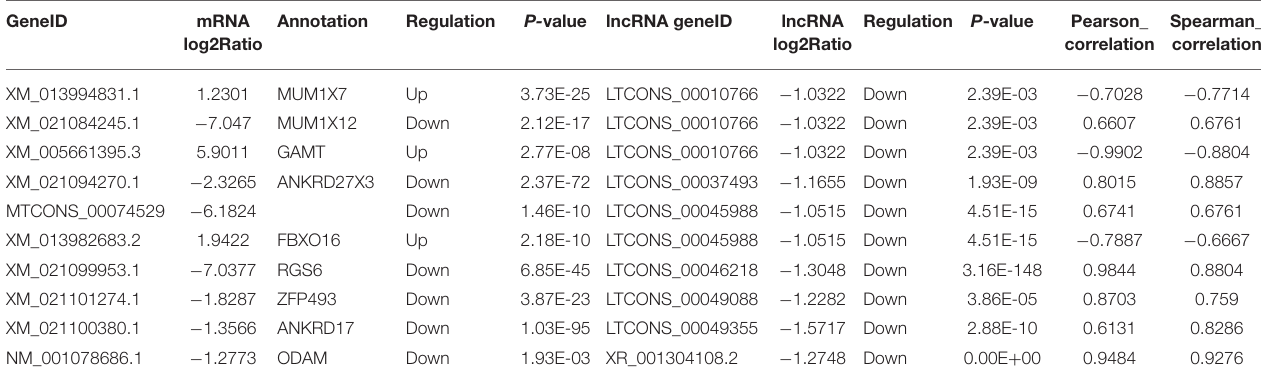
TABLE 6 | Correlation analysis between differentially expressed mRNAs and lncRNAs. GeneID mRNA Annotation Regulation P- value lncRNA geneID lncRNA log2Ratio